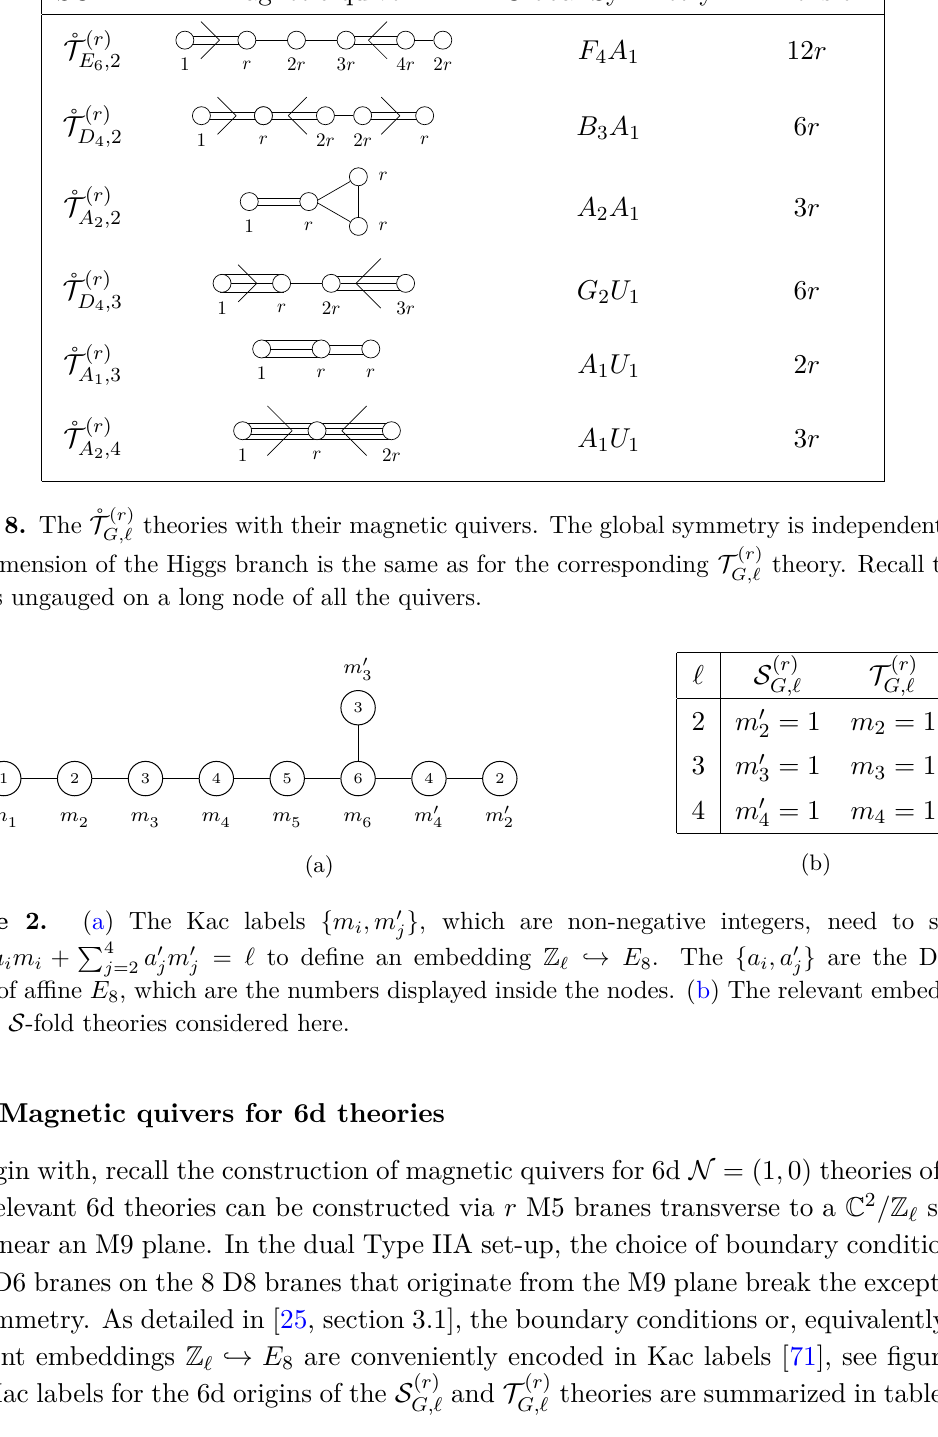
0 } are the i , a j